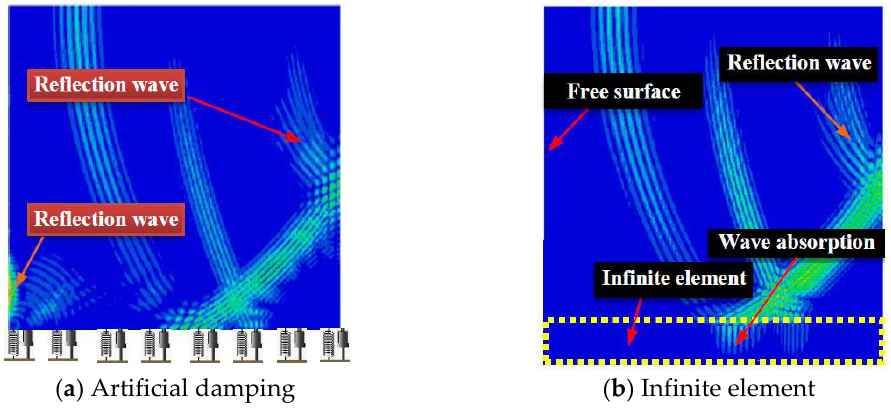
Figure 7. Comparison of absorption efficiency of different boundaries.